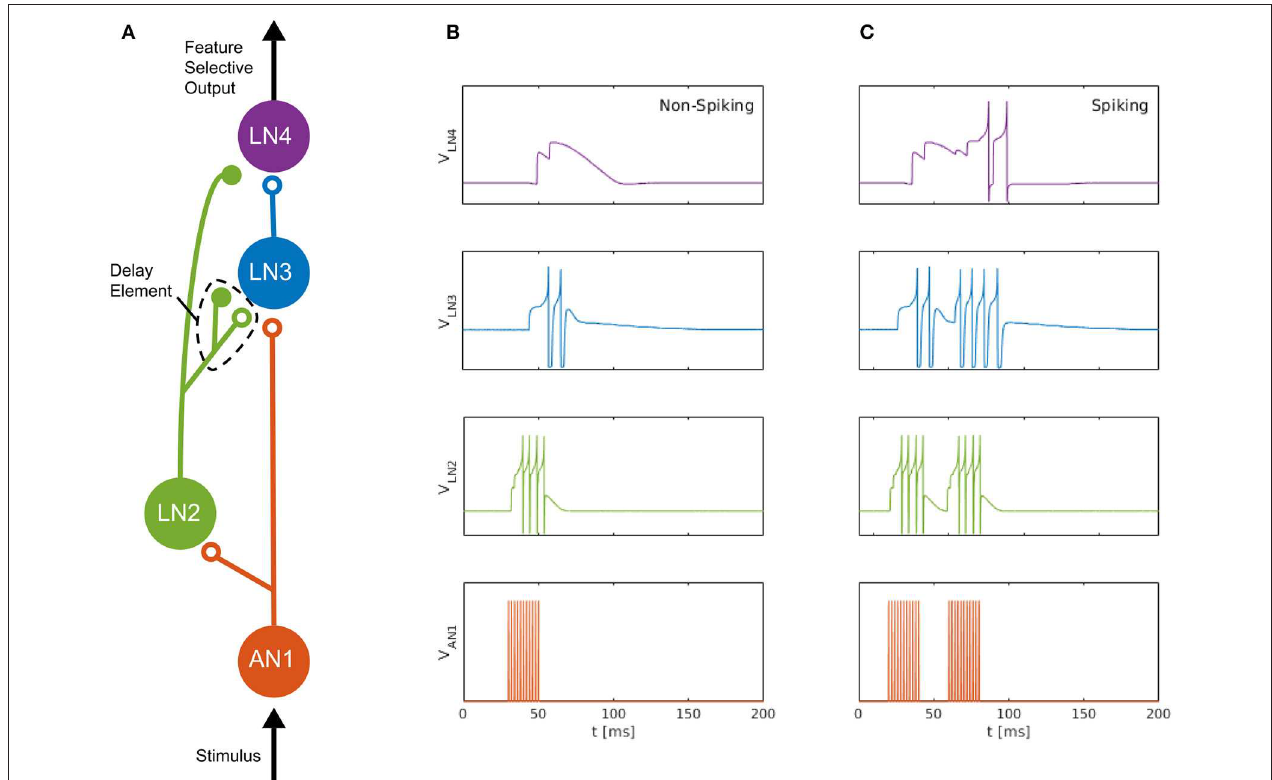
FIGURE 1 | Neuromorphic feature detection circuit inspired by an auditory feature detection circuit in field crickets. (A) SNN architecture comprising four spiking neurons, on which open circles and solid disks denote, respectively, excitatory and inhibitory synapses. The disynaptic delay element imitates the dynamics of the non-spiking delay neuron, LN5, in the feature detection circuit of the cricket ( Schöneich et al., 2015). (B) Measured neuron membrane potentials in the DYNAP-SE, following a 20-ms pulse stimulus. (C) Similarly, membrane potentials resulting from a pair of 20-ms stimulus pulses with a 20-ms interval, which causes the feature detecting neuron, LN4, to fire. By overcoming its inhibition and spiking, LN4 signals the feature detection.